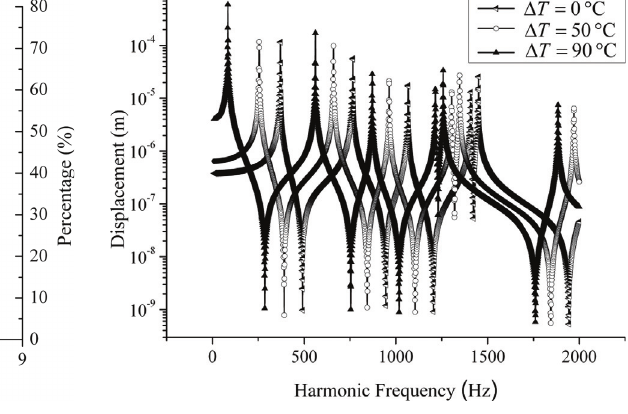
Fig. 9. Natural frequencies and their relative difference. Fig. 10. Displacement.